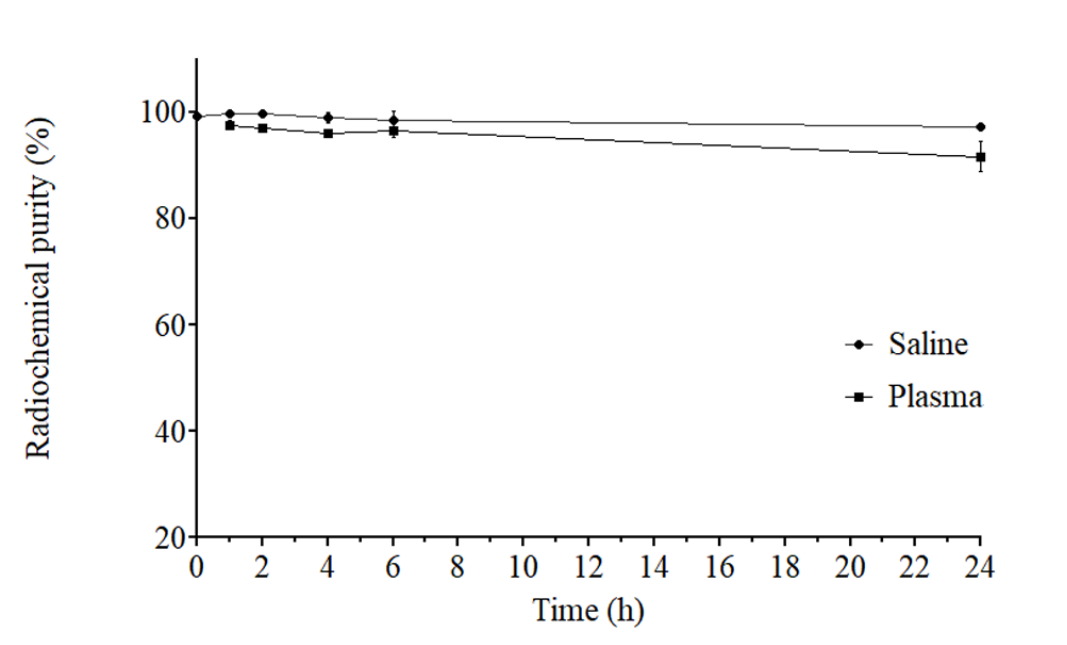
FIGURE 3 - In-vitro stability of 99m Tc-CDV as a function of time in the presence of saline, at room temperature, and in the presence of mouse plasma, at 37 °C